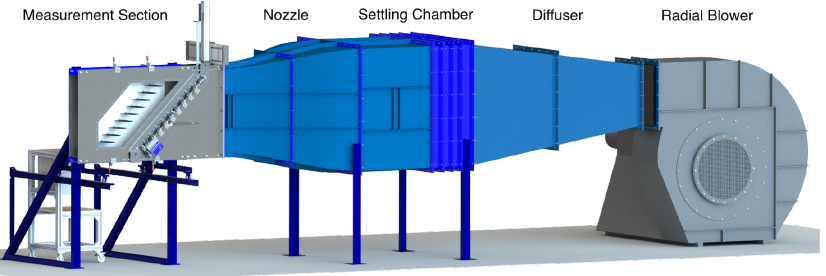
Figure 5. Experimental test rig architecture.